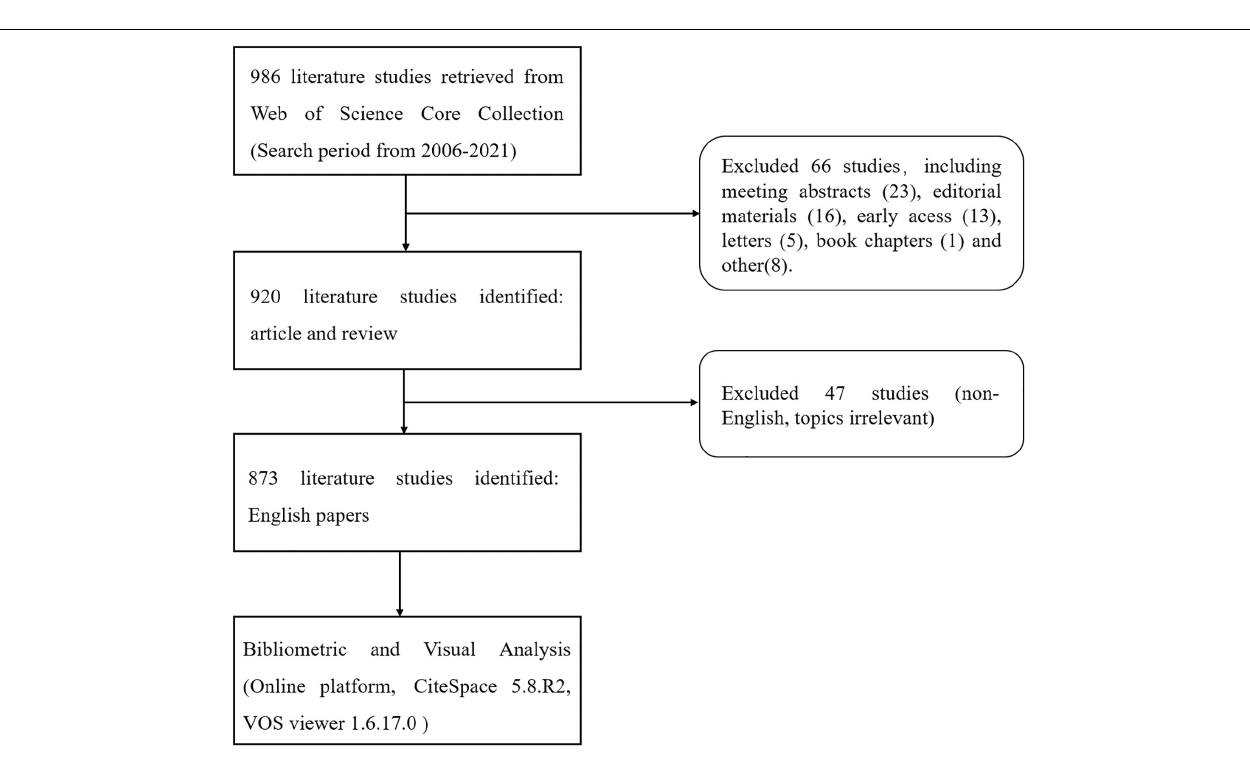
FIGURE 1 | The pathways and mediators of bidirectional communication between cardiovascular system and gut microbiota.